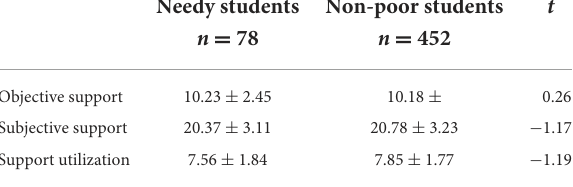
TABLE 5 Comparison of the social support dimensions between needy students and non-poor students.